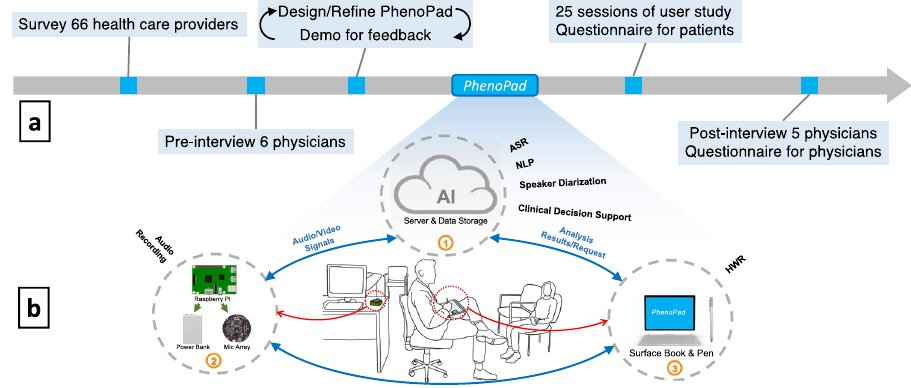
Fig. 1 Study overview and system architecture. a Overview of our study methodology. b System architecture of PhenoPad: 1. Cloud server with data storage; 2. Audio capturing devices including a Raspberry Pi, a microphone array, and a power bank; 3. Note taking devices including a Microsoft Surface Book and a Surface